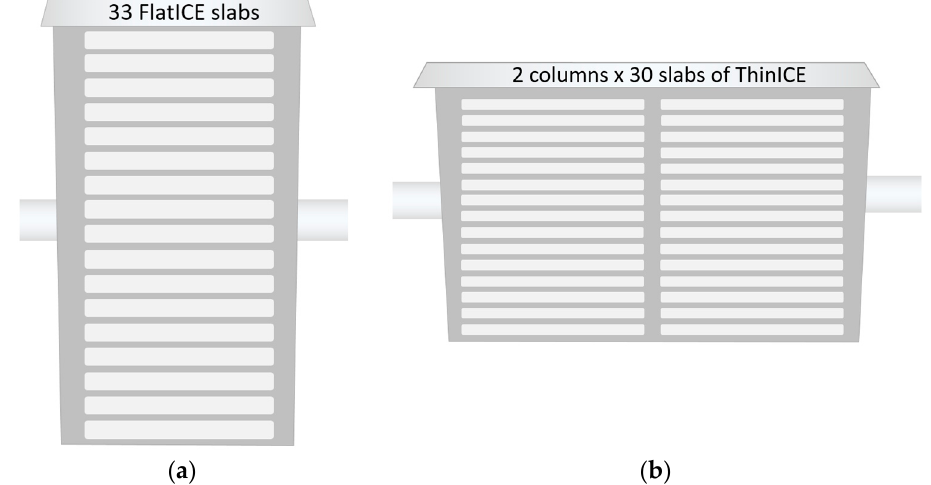
Figure 7. Scheme of the optimized configurations for ( a ) Flat-ICE and ( b ) ThinICE slabs.